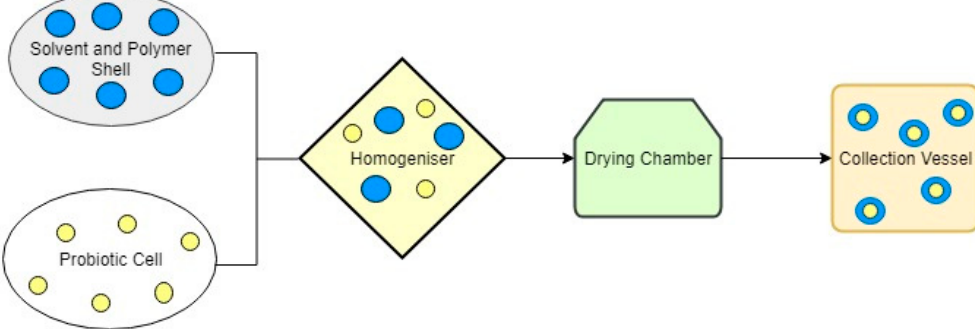
Figure 2. Schematic diagram of the probiotic encapsulation process.